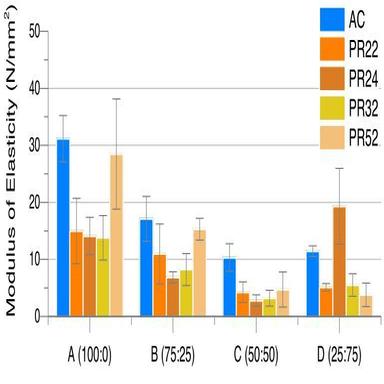
Modulus of elasticity.